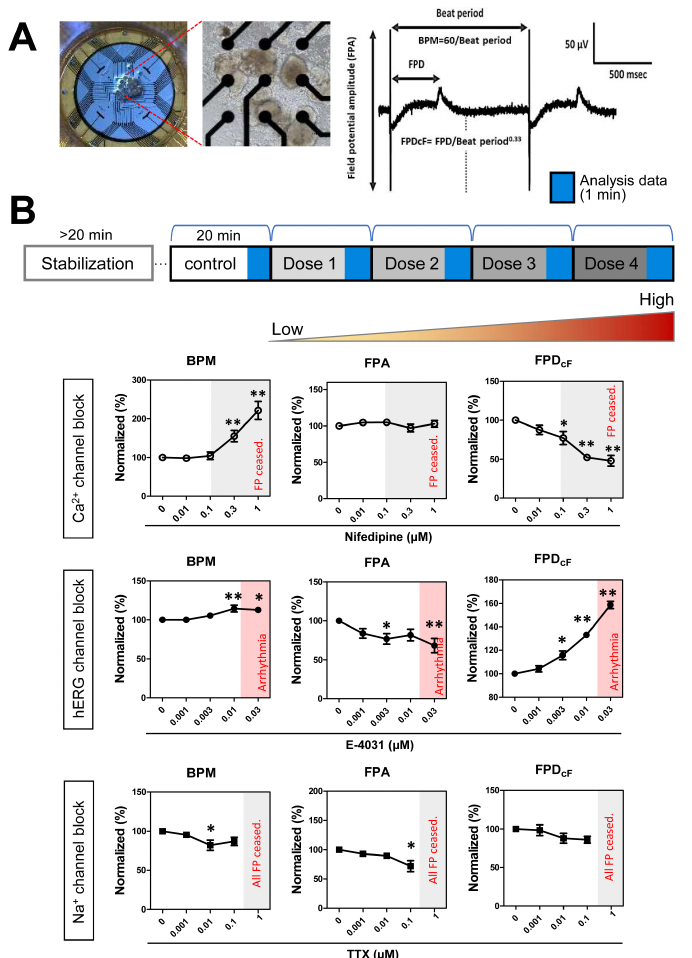
Figure 7. Effects of ion channel blockers on field potentials (FPs) of iPSC-hCOs: ( A ) Photographs of iPSC-hCOs on MEA plate (left) and FP parameters (right). ( B ) Schematic experimental schedules for MEA assay (top) and the effects of nifedipine ( n = 7), E-4031 ( n = 6), and Tetrodotoxin (TTX, n = 3). BPM, beats per minute; FPA, field potential amplitude; FPD cF , Fridericia’s formula to correct the FP duration dependence on beating rate. Data are presented as the mean + SEM. * p < 0.05, ** p < 0.01, by Dunnett’s